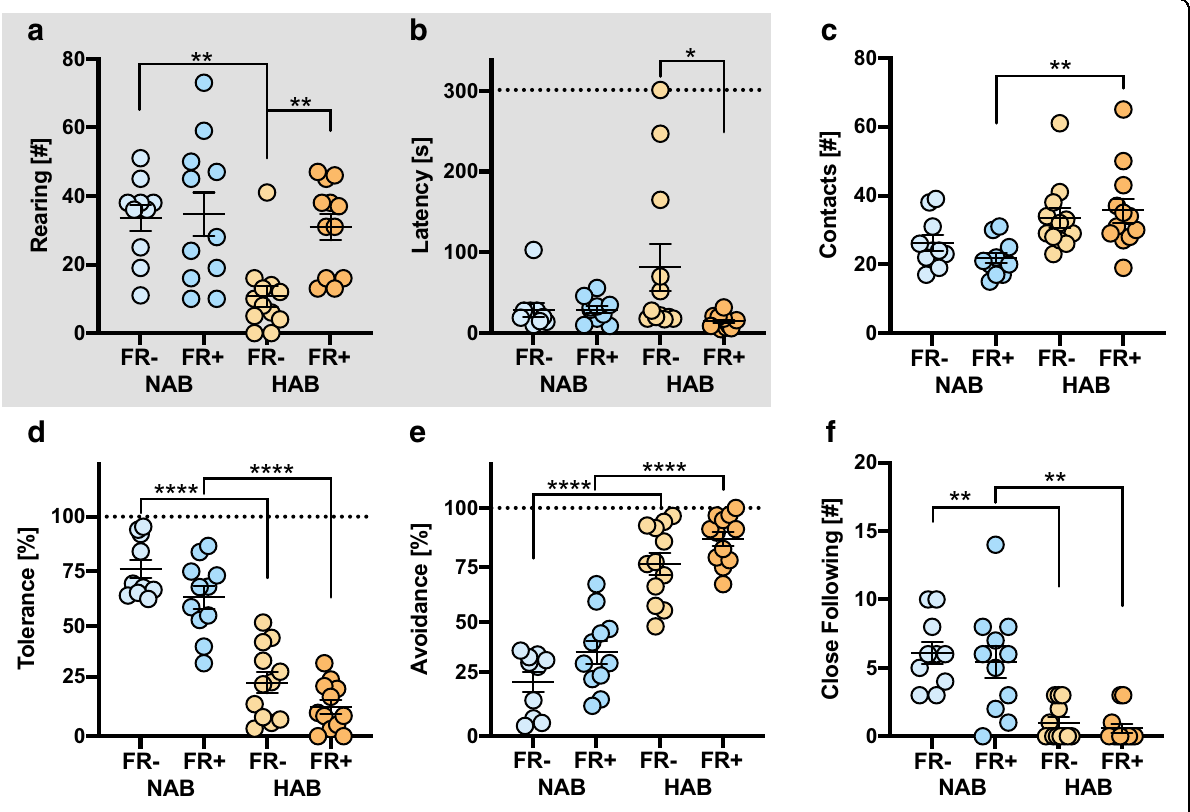
Fig. 4 Beetle mania task (BMT). a , b Vertical (number of rearings) and horizontal exploration (latency until the animals have explored the other end of the 1 m arena) during the 5-min baseline exposure to the BMT setup without robo-beetle. c – f Behavioral responses to an erratically moving robe- beetle. Data shown in d and e were normalized to the number of contacts ( c ). For further details, see Fig.